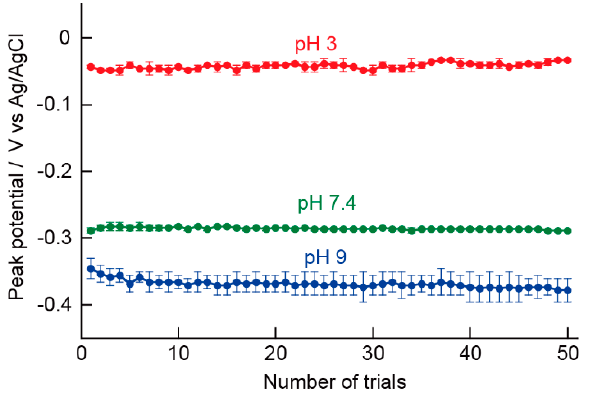
Figure 6. Changes in the peak potential during the repeated DPV measurements in phosphate buffer solution (100 mM) at pH = 3, 7.4, and 9 using the (PAH/AA-PMA) 5 -modified electrode.